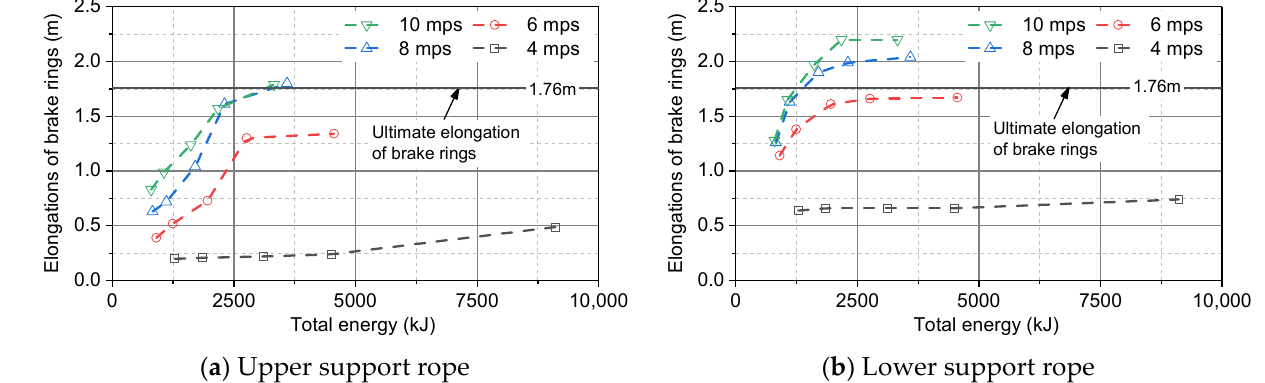
Figure 16. Elongation of brake rings.